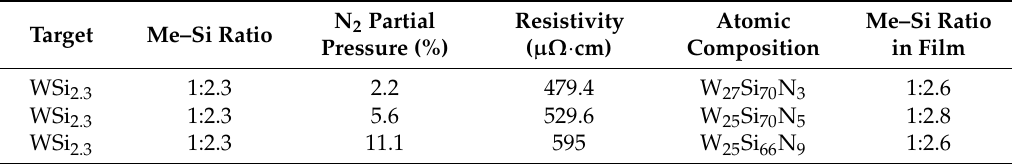
Table 2. Atomic composition of ternary metal silicon nitride barrier layers tested in this study as determined by AES